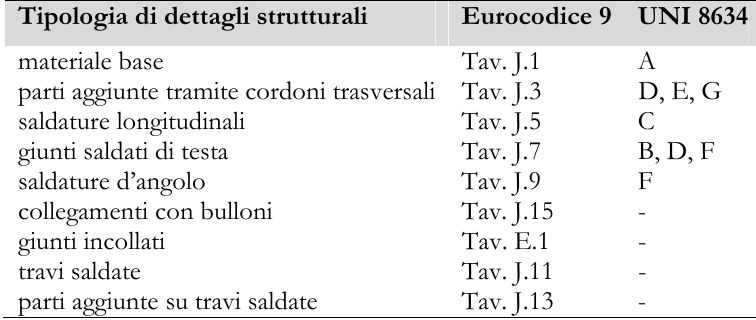
Tabella 3: Tipologie di dettagli strutturali considerate nell’ Eurocodice 9 e nella UNI